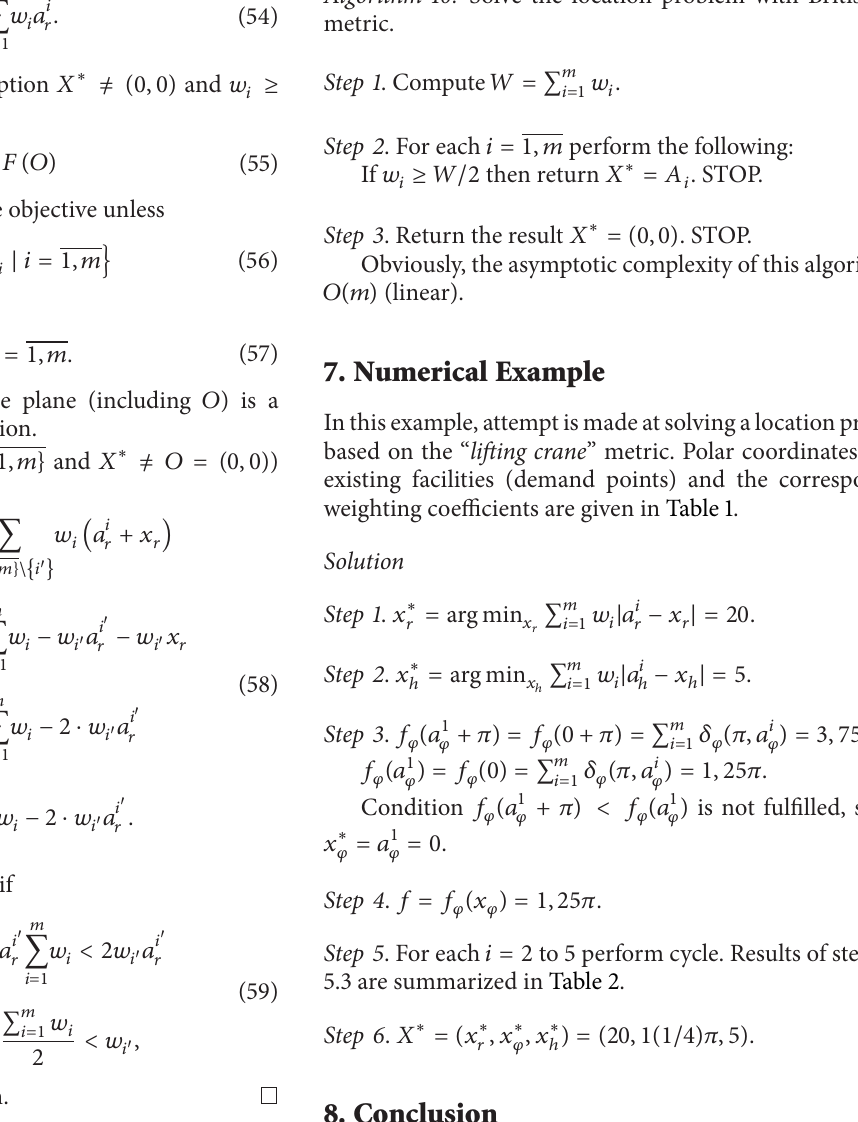
Algorithm 10 is proposed. Algorithm 10. Solve the location problem with British